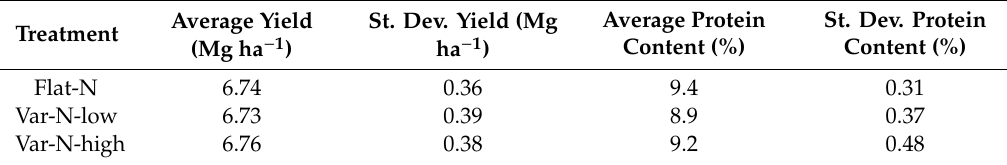
Table 2. Grain yield and protein content for the three N fertilization treatments: Flat-N (standard rate of 120 kg N ha − 1 ), Var-N-low (variable rate from 60 to 120 kg N ha − 1 ), Var-N-high (variable rate from 90 to 150 kg N ha − 1